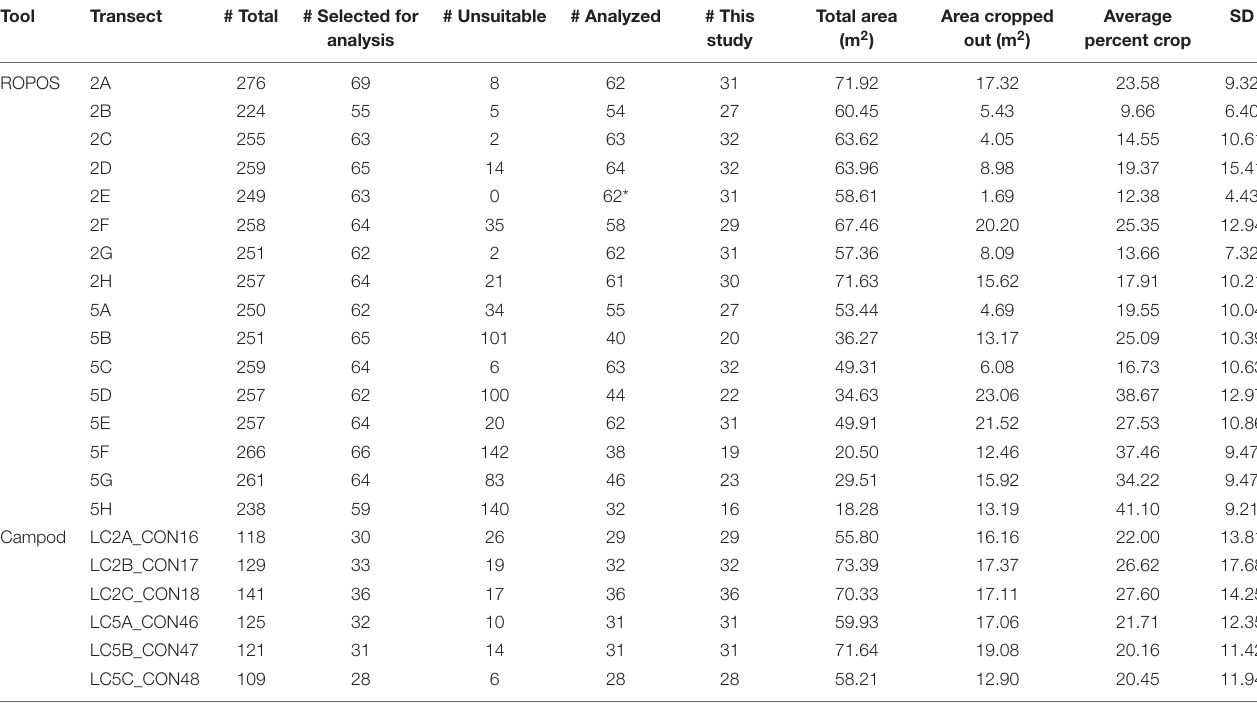
FIGURE 4 | Examples of the most abundant taxonomic groups (scale bars are 2 cm). (A) Actiniaria (O.) sp. 23, (B) Actiniaria (O.) spp., (C) Anthoptilum spp., (D) Pennatula sp. 2, and (E) Scleractinia (O.) spp. TABLE 1 | Quality of imagery collected by the ROV ROPOS and the drop camera Campod, by 400-m transects at stations LC2 and LC5 in the Laurentian Channel